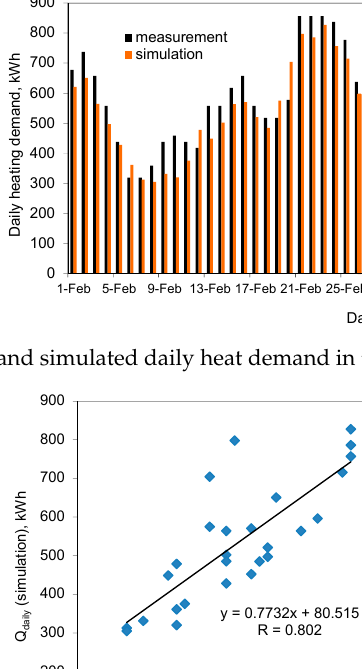
y = 0.7732x + 80.515 R = 0.802